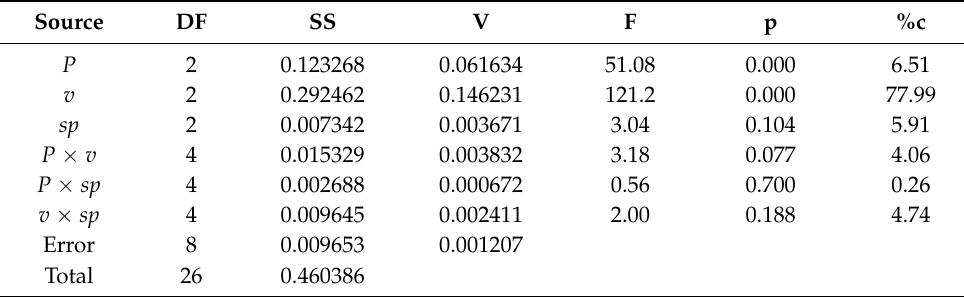
Table 8. The ANOVA table for